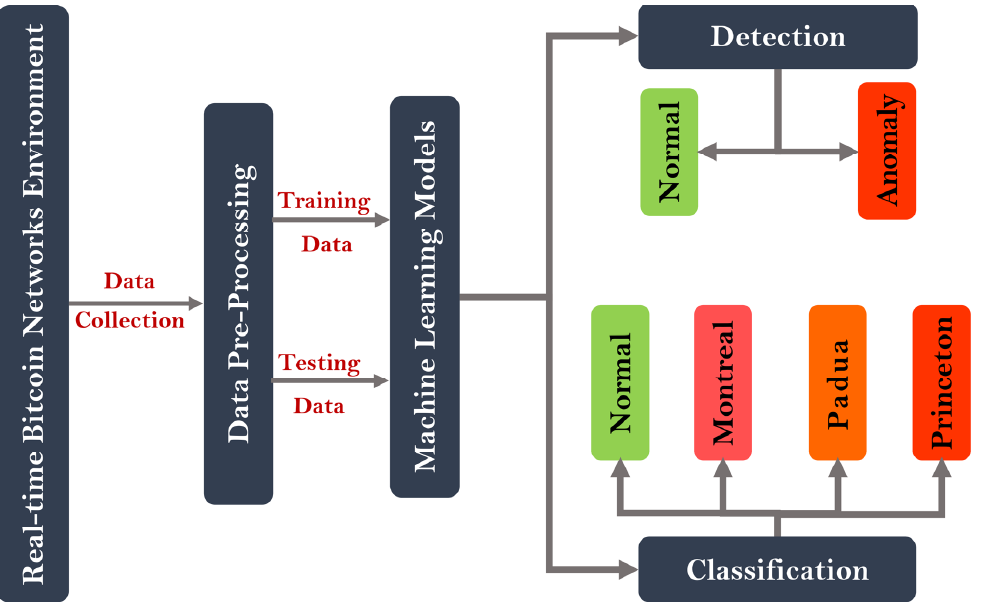
Figure 4. Architecture of machine learning-based Bitcoin Transaction Predictive Model.